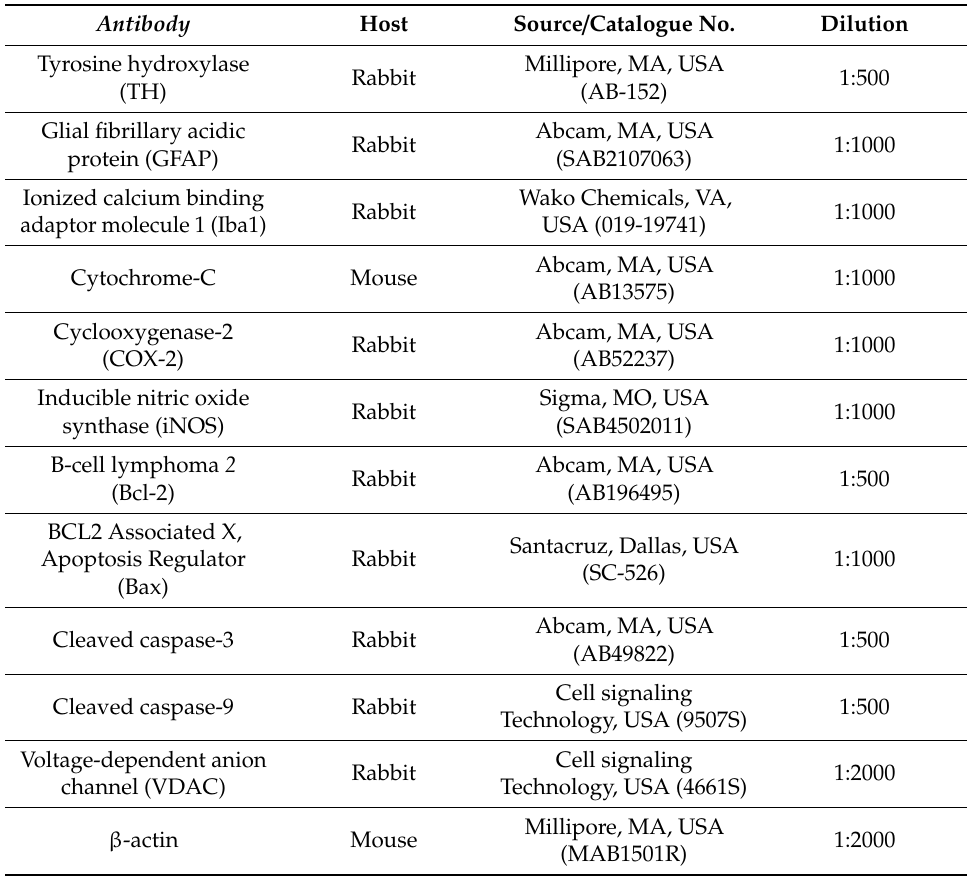
Table 1. Primary antibodies used, source, and